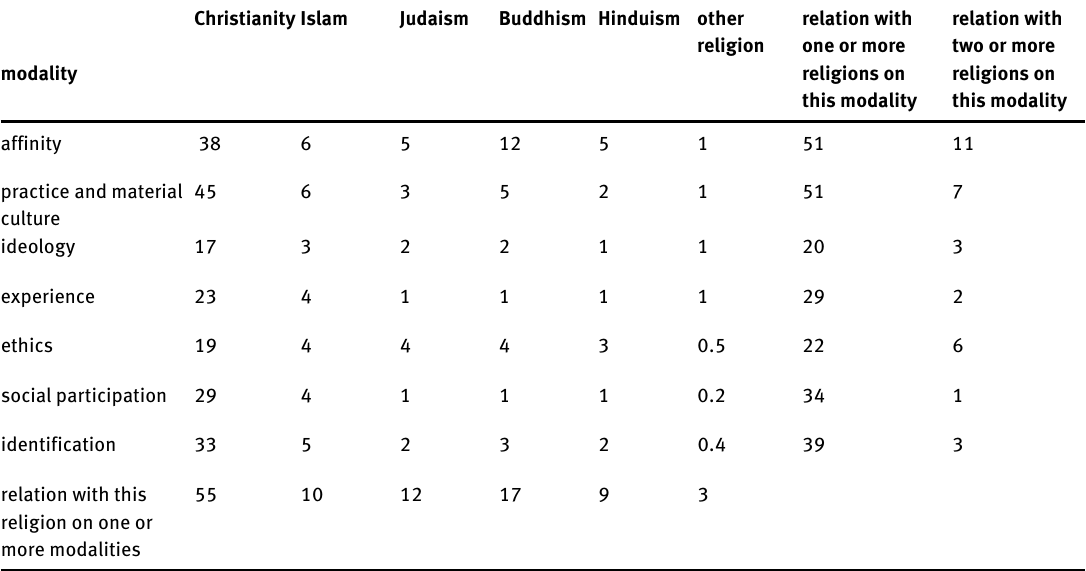
Table 3. Relation with different religions per modality of belonging (in per cent of the